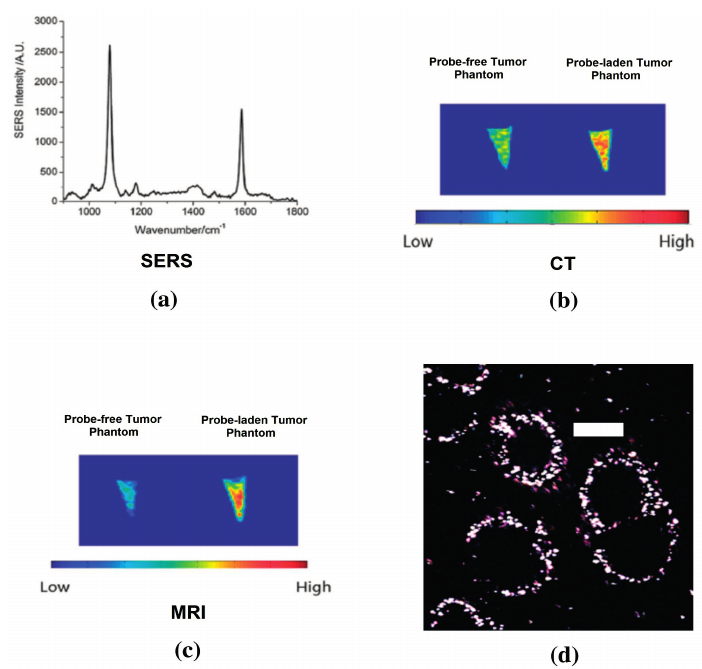
Figure 4. ( a ) SERS signal detected from cells with AuNSs multimodality probe; ( b , c ) CT